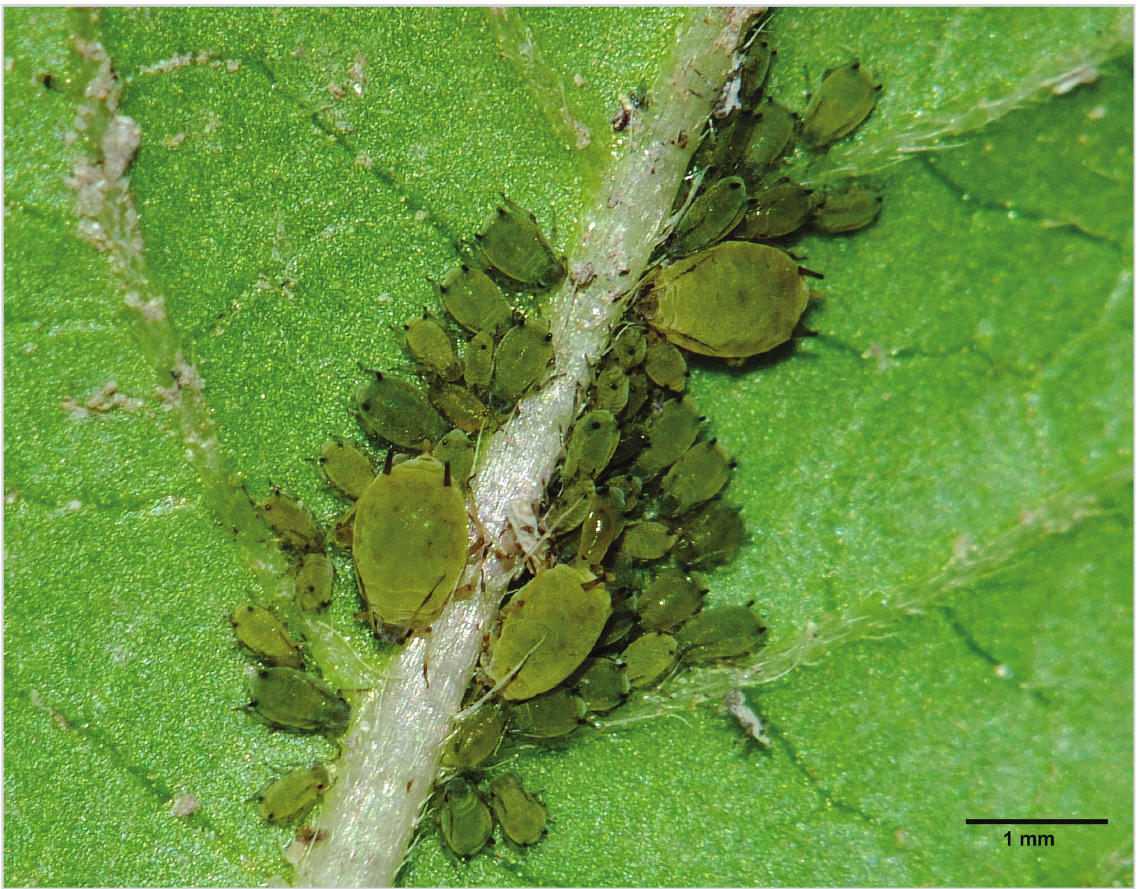
Fig. 24. Aphis beccabungae Koch, 1855. Apt. and juv. on Galeopsis speciosa . A. beccabungae is very similar to A. gossypii Glover,